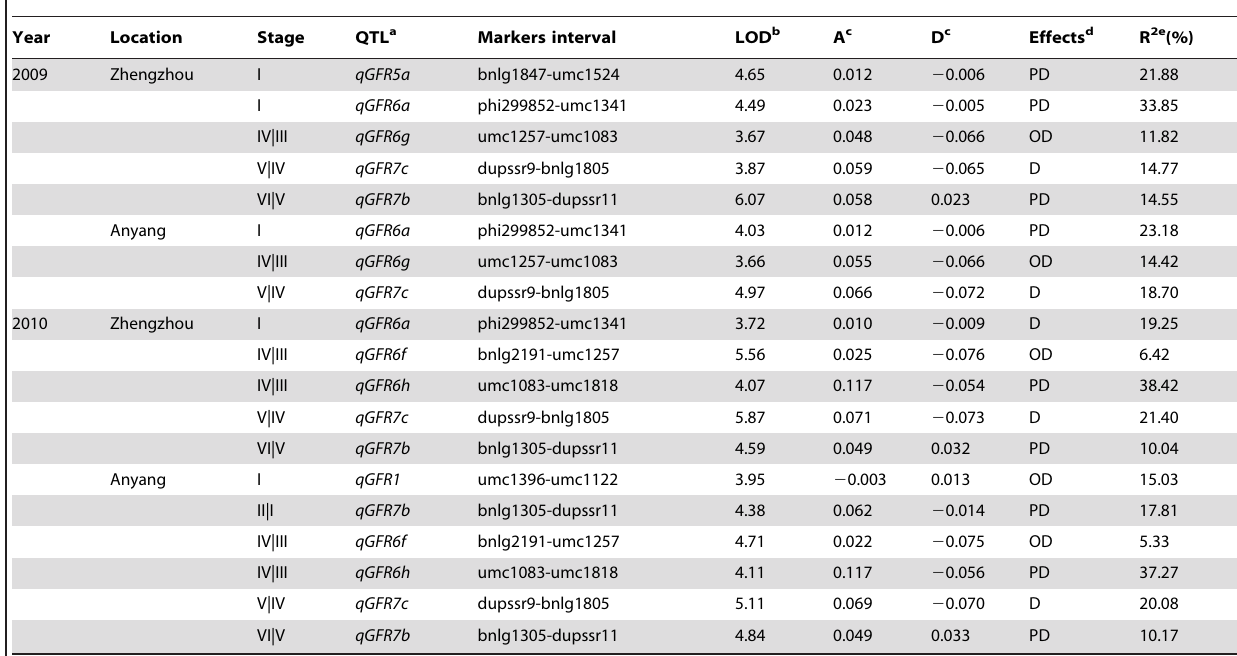
Table 4. Conditional QTLs detected for grain filling rate in the immortalized F 2 population.